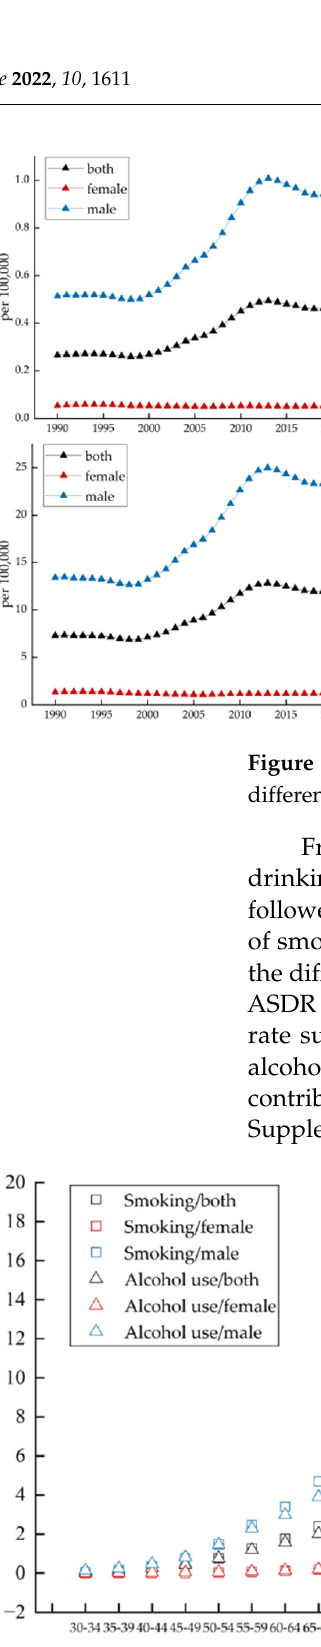
Figure 4. The variation trend of ASDR and age-standardized DALY rate of two risks in different genders and age groups in